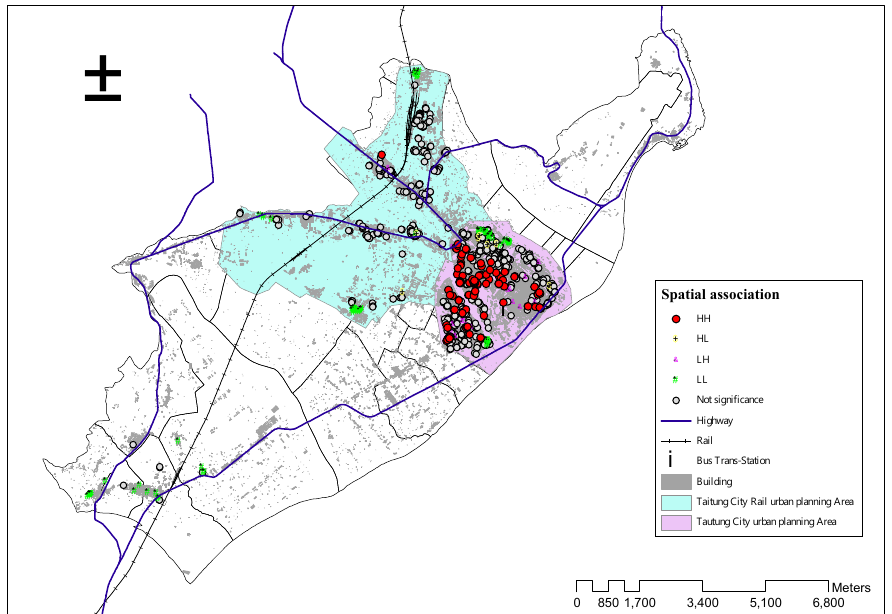
Figure 4. Spatial correlation map of real estate unit price in 2014.